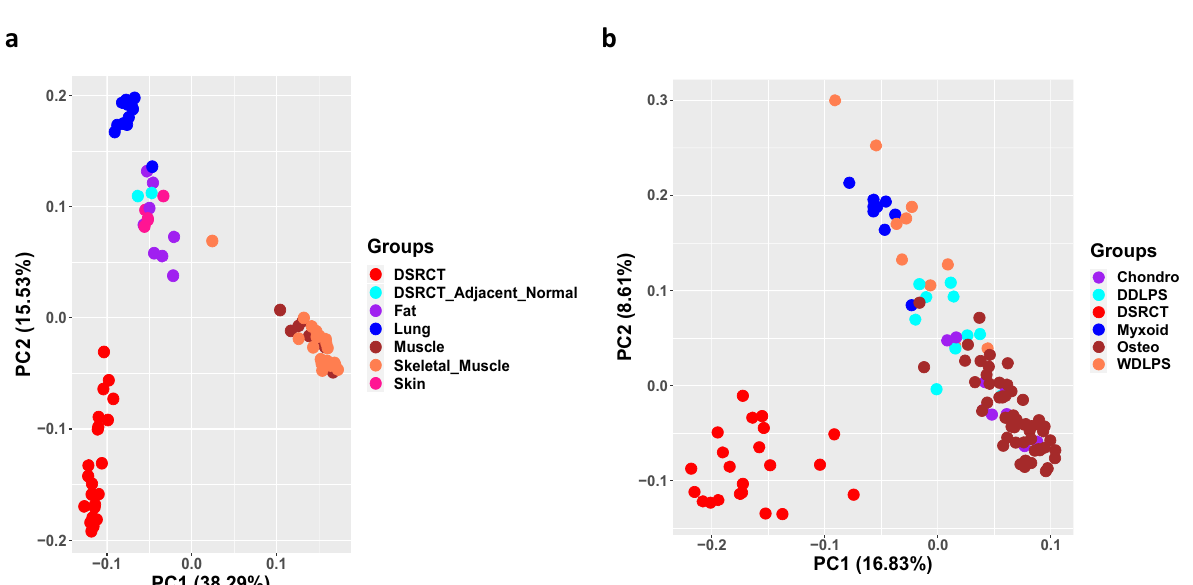
Fig. 5 Principal component analysis (PCA) analysis. a Gene expression comparison between DSRCT samples and normal samples of several tissues in MDACC. b Gene expression comparison between DSRCT samples and other types of